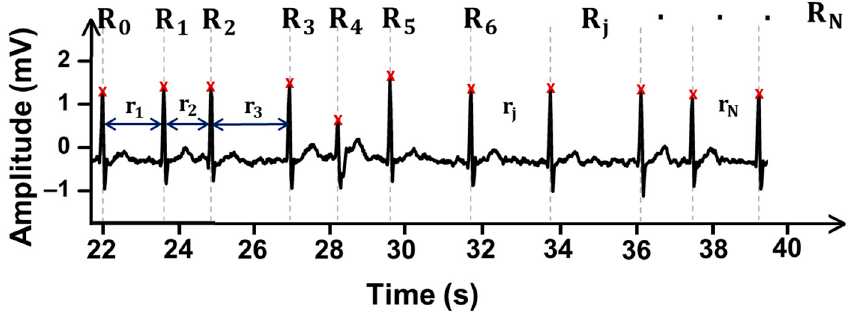
Figure 3. The electrocardiography (ECG) is composed of N + 1 R-waves and N RR intervals. Each 𝑟 (cid:3037) is mapped onto a particular symbol 𝑣 (cid:3036) 𝜖 𝕍 of the vocabulary 𝕍 , and its car-